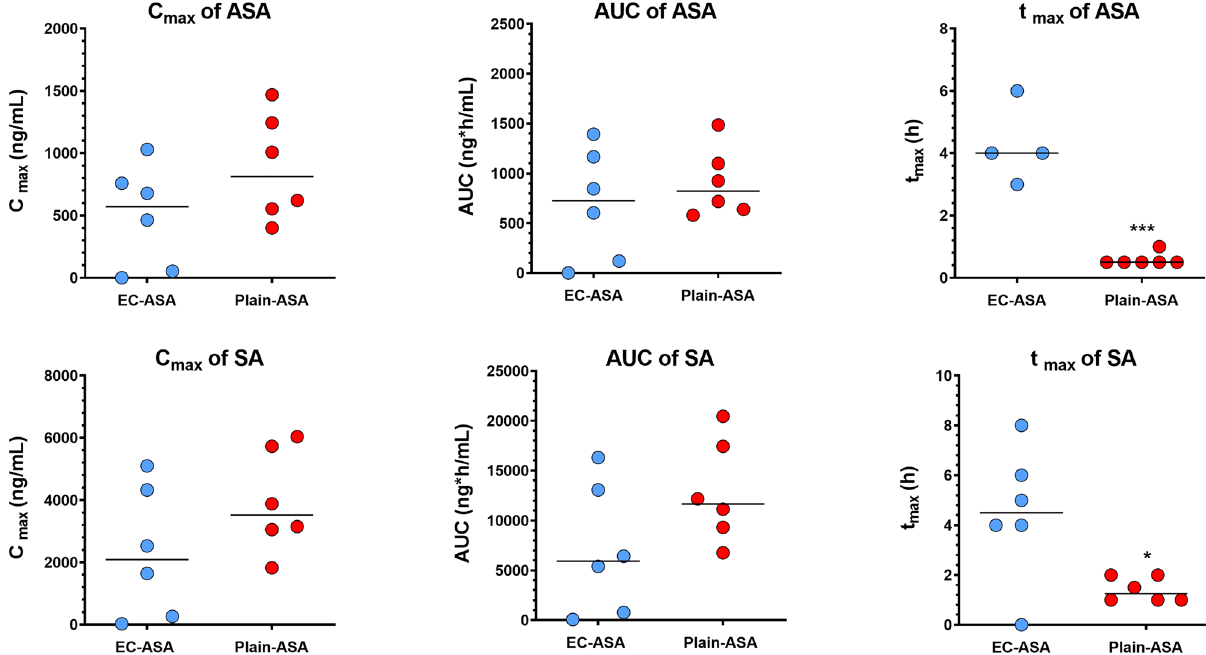
Figure 6. PK parameters of ASA (above) and SA (below) in 6 HS after EC-ASA (blue) and plain-ASA (red) administration. Only T max of ASA and SA were significantly different between the two treatments. To note that t max after EC-ASA administration could be calculated only on n = 4